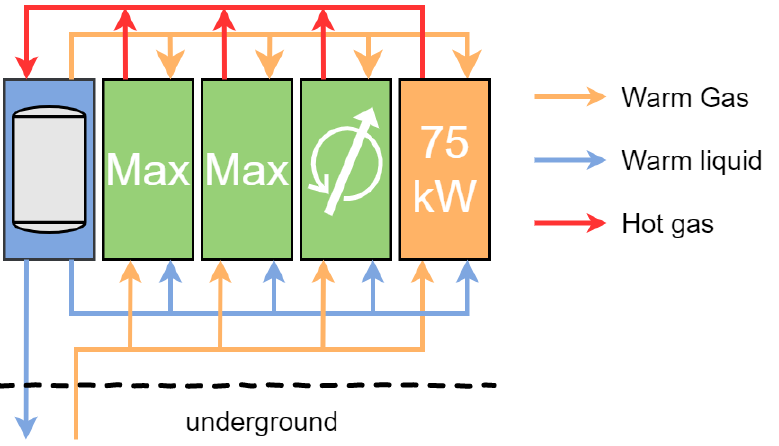
Figure 2. Modular design with common equipment module in blue integrating the receive feeding the evaporator underground and multiple compressor modules. Two green compressor units are operating at maximum cooling capacity (expected around 75kW for final units), one is regulating the gas return pressure from underground and the orange one is a redundant compressor